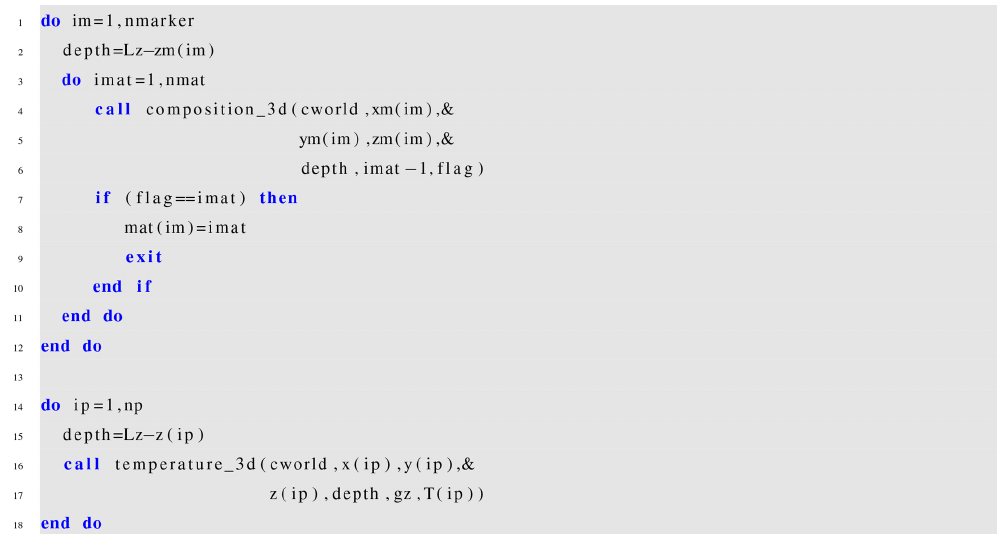
Figure 6. Example ELEFANT query routine using the GWB-supplied Fortran wrappers composition_3d() and temperature_3d(): (a) a loop runs over all markers and determines for each the composition at its location; (b) a loop runs over all grid points and the GWB returns its temperature as a function of their spatial coordinates.